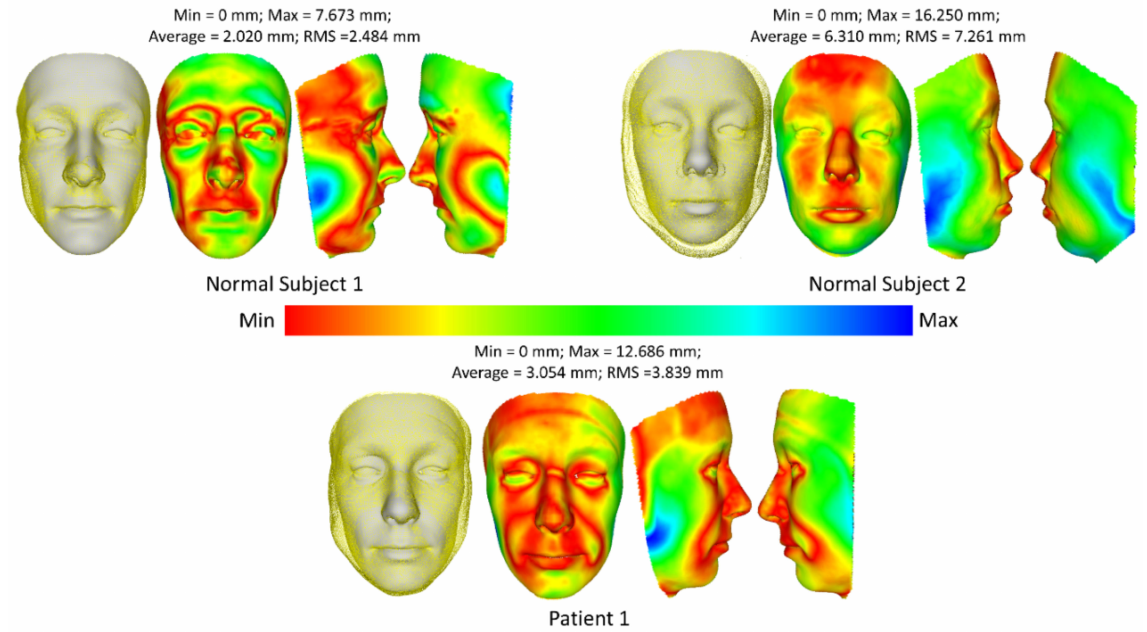
Figure 7. Comparison of 3D face reconstruction (grey) and 3D face reconstruction from MRI (yellow) using the first method (fitting a 3DMM).